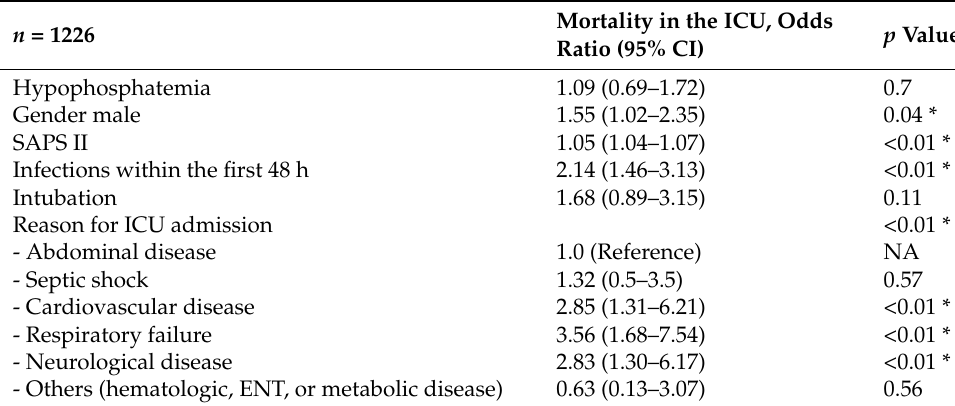
Table 2. Hypophosphatemia and mortality in the